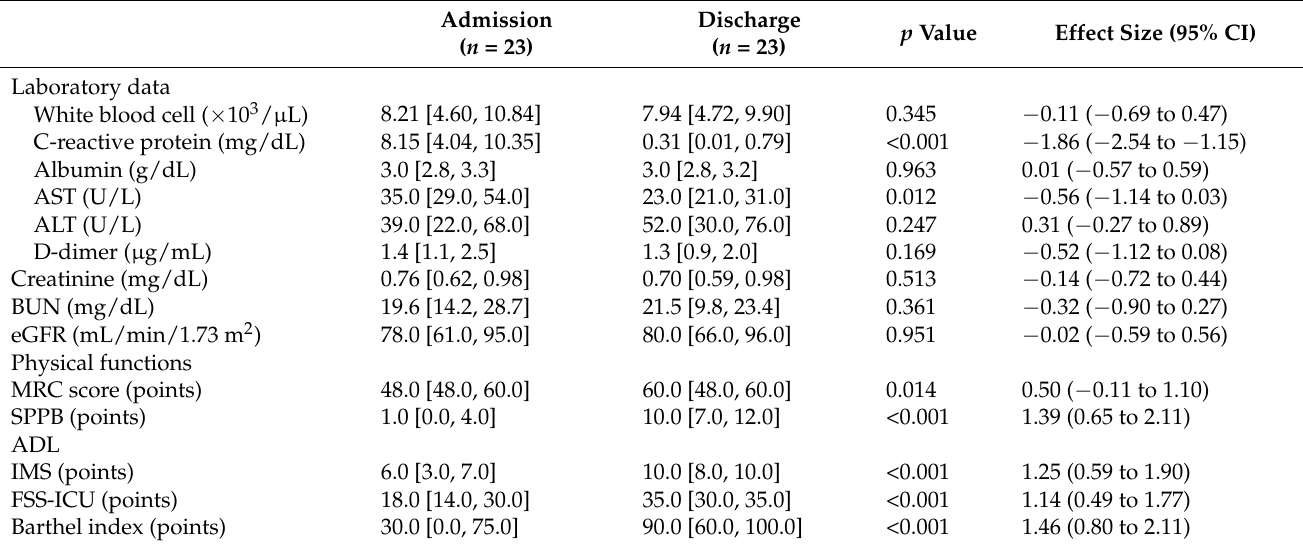
Table 2. Changes in laboratory data, physical function, and ADLs from admission to discharge.